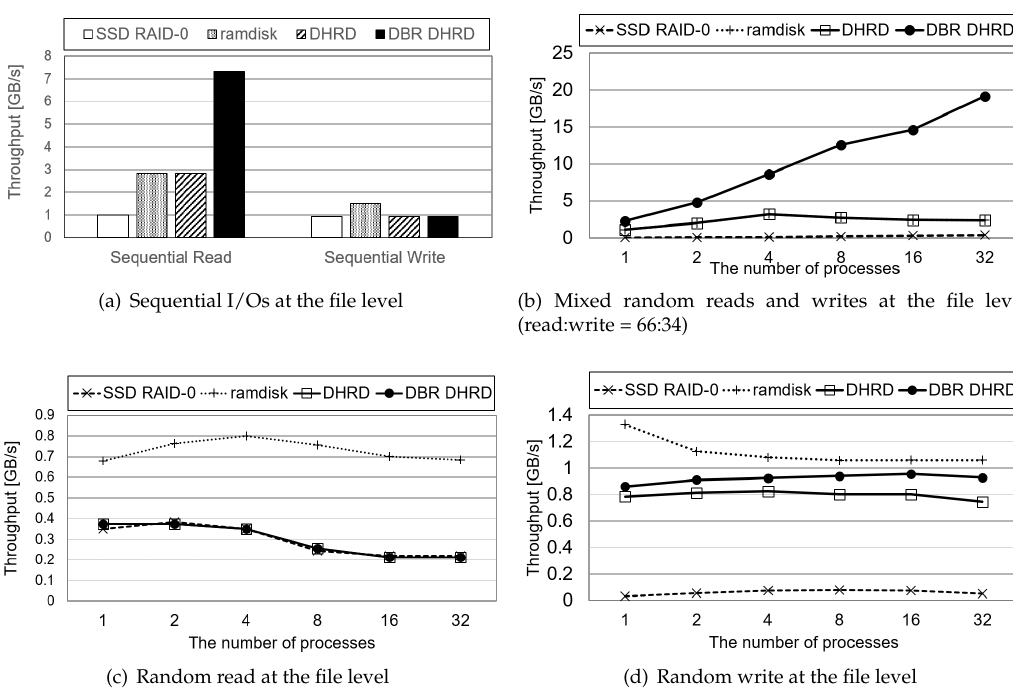
Figure 8. The results of file-level benchmark evaluation. It plots throughputs of sequential I/O, random read, random write, and mixed random read and write workloads at file level.